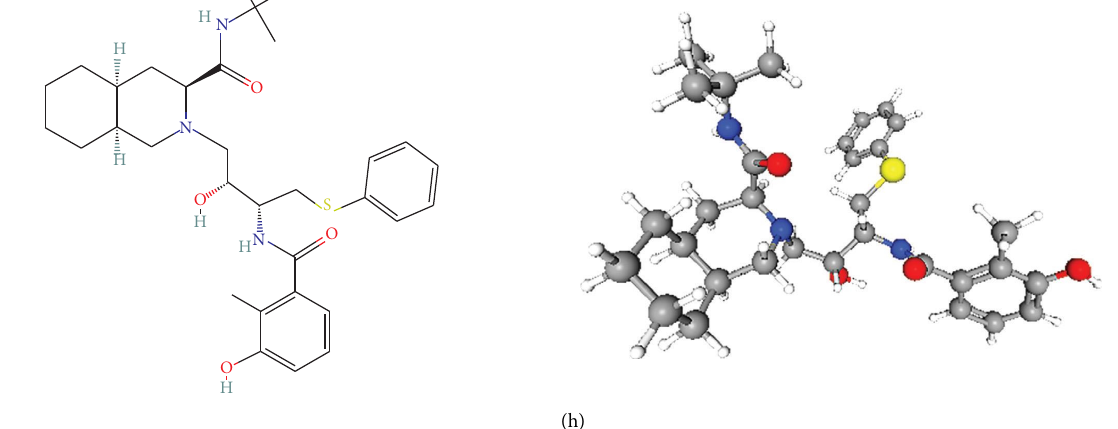
Figure 1: 2D and 3D Structures of SARS-CoV-2 Inhibitors: (a) baicalein, (b) baicalin, (c) candesartan cilexetil, (d) chloroquine, (e) cinanserin, (f) dipyridamole, (g) hydroxychloroquine, and (h)